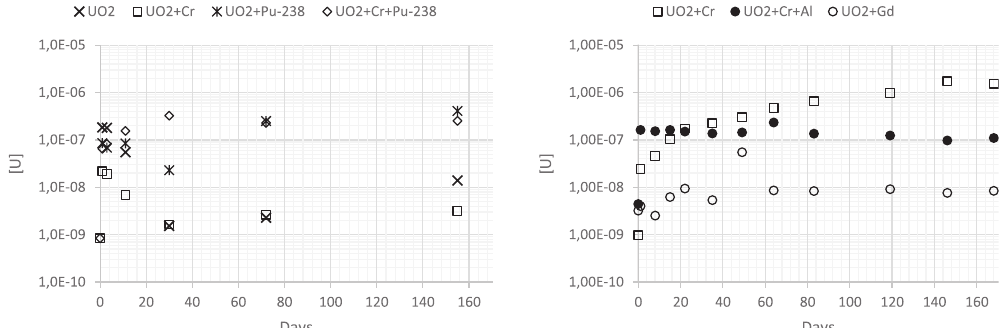
Fig. 8. Uranium concentration in aqueous solution vs. time for undoped and doped UO 2 in experiments with hydrogen in the gas phase. Left: data from SCK CEN (10 bar hydrogen). Right: data from Ciemat (initially 8 bar with 5% hydrogen; NB, some air contamination